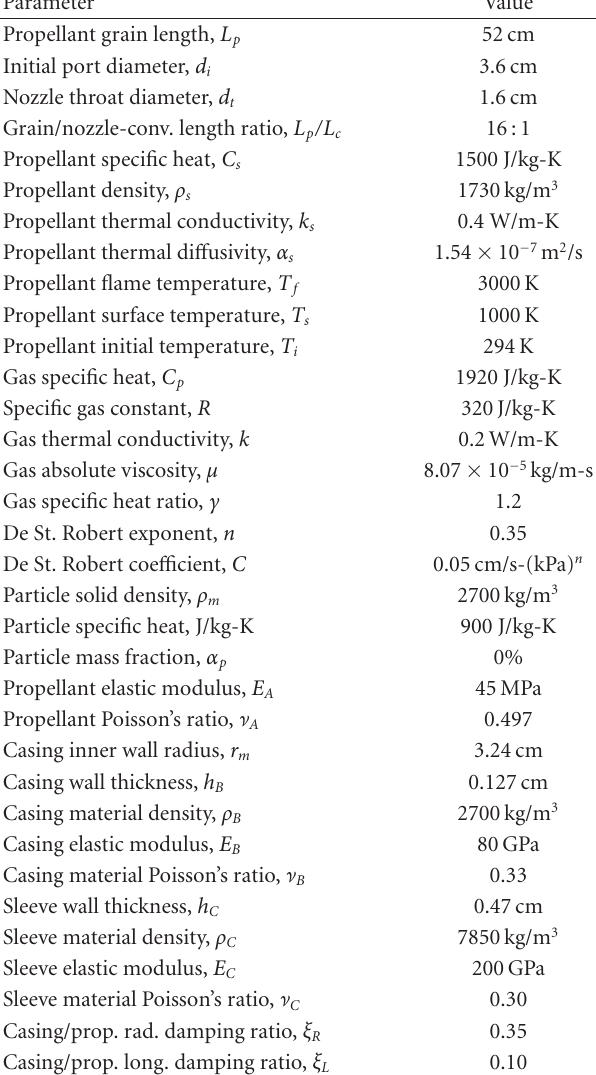
Table 1: Reference motor characteristics.